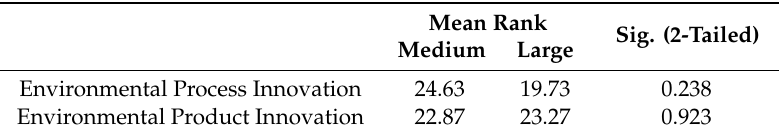
Table 6. Mann–Whitney U test results.